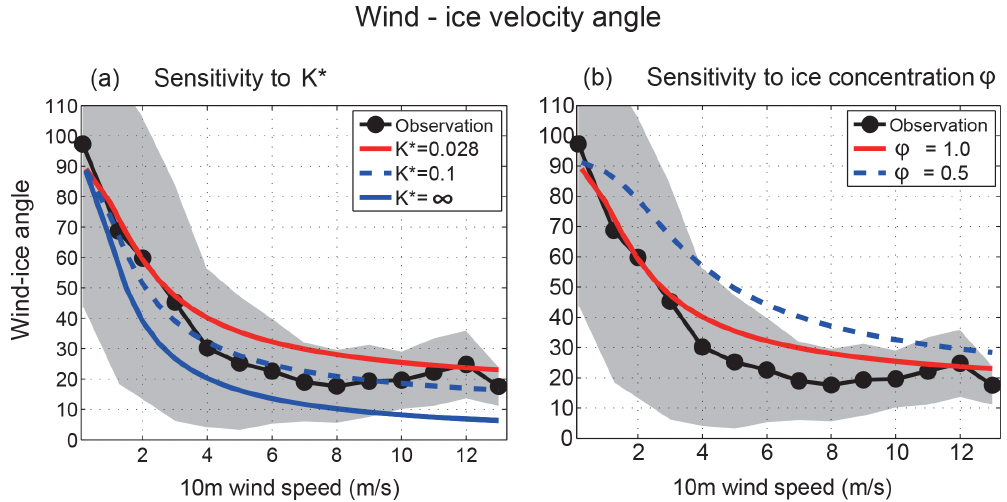
Figure 4. The velocity angle (clockwise rotation angle) between the 10m winds and the ITP-V 35 ice floe as functions of the 10m wind speed (ms − 1 ). Note that typically the ice velocity lies to the right of the wind velocity. In each plot the black line is the mean observed value from the ITP-V 35 data set, binned by wind speed, and the gray shadings indicate the range of 1 standard deviation from the mean. In (a) , the red, dotted blue, and solid blue lines correspond to our analytical model, described in Sect. 2, with vertical diffusivities K ∗ o = 0.028, 0.1, and ∞ (no IOBL), respectively. In (b) , the red and blue lines correspond to 100% ( ϕ = 1) and 50% ( ϕ = 0.5) sea ice concentrations, in each case using the canonical vertical diffusivity K ∗ o =